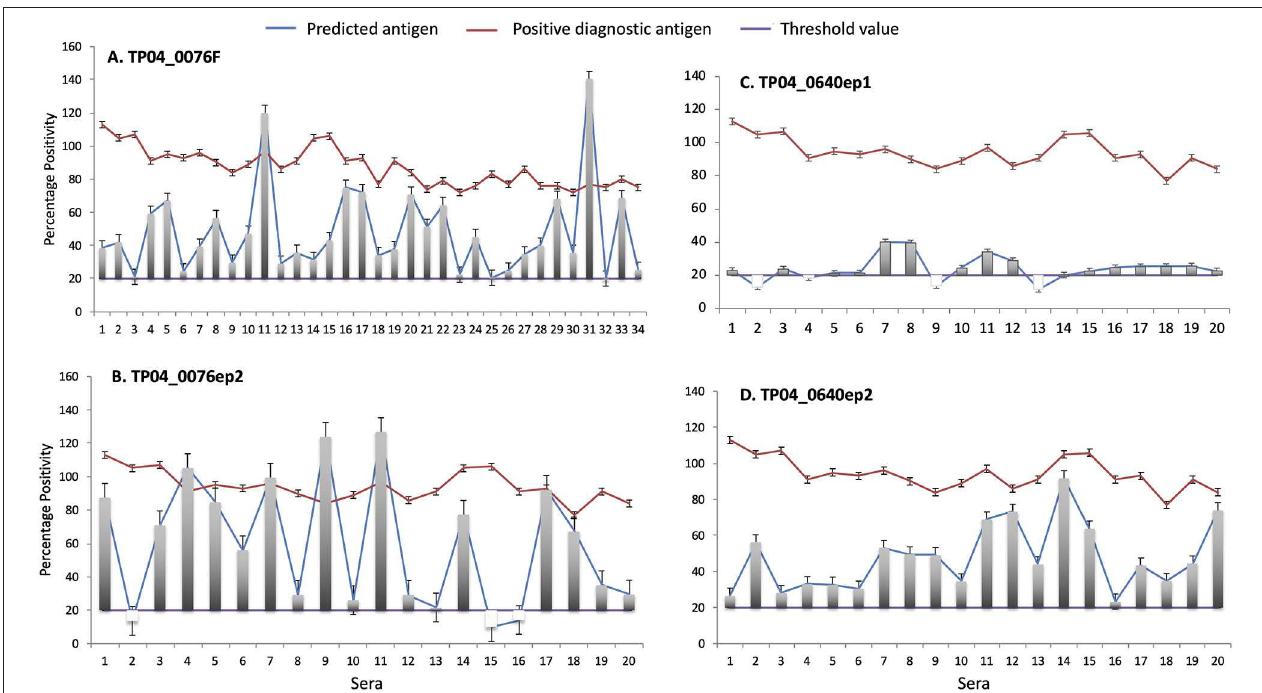
FIGURE 8 | Enzyme-linked immunosorbent assay (ELISA) evaluation of the antigenicity of (A) TP04_0076 gene product (recombinant protein TP04_0076F) and predicted antibody target epitopes of TP04_0640 and TP04_0076 gene products (synthetic peptides (B) TP04_0076ep2, (C) TP04_0640ep1, and (D) TP04_0640ep2). A panel of 34 predetermined bovine positive controls with strong percent positivity ( PP ≥ 80) to PIM antigen (red line) were included in the analysis. The PP results of each of the four recombinant proteins and synthetic peptides tested (blue line) are shown in separated panels. The green line represents the cutoff, and an assay with a PP ≥ 20 ( PP ≥ 20) is considered